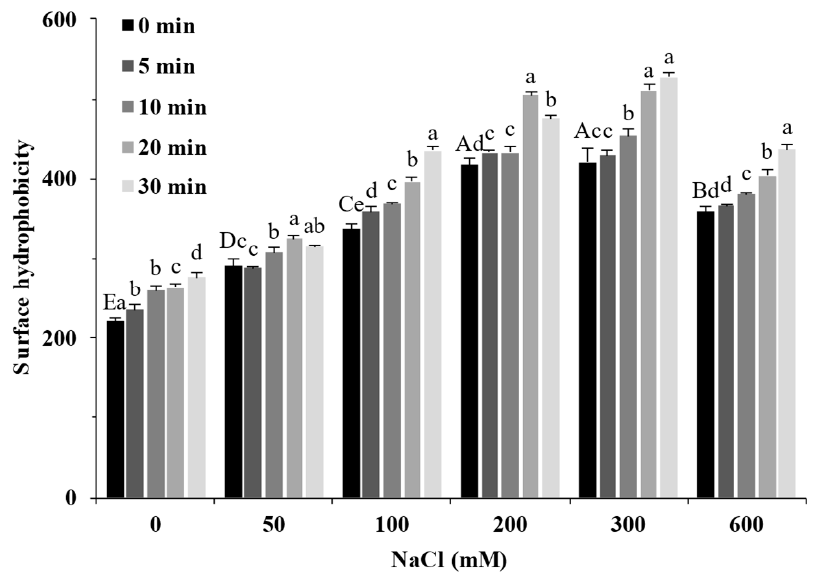
Figure 3. Surface hydrophobicity of soy protein isolate treated by ultrasound at different NaCl concentrations for different processing times. The upper letters indicate significant differences between the samples without ultrasound treatment in different salt concentrations. The lower letters indicate significant differences between the samples with different ultrasound times in the same salt concentration ( p < 0.05).